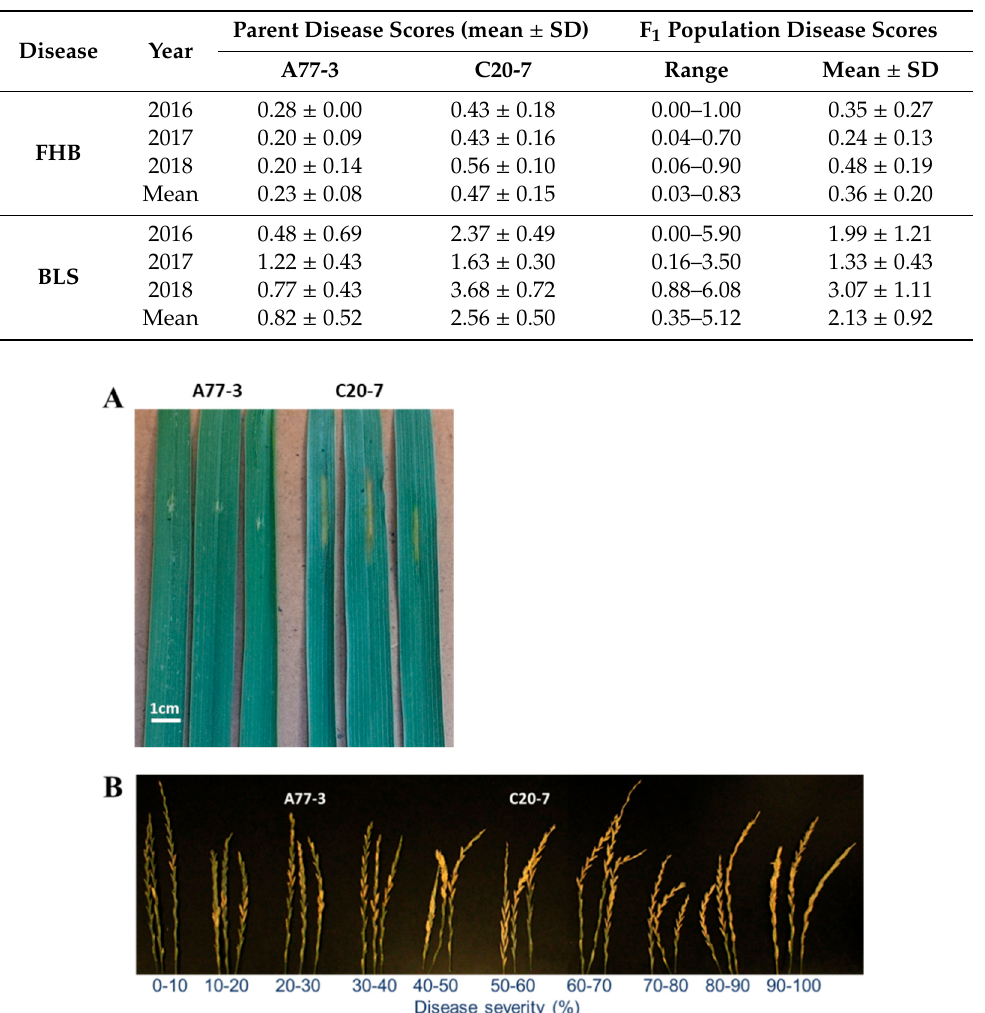
Table 1. Distribution of phenotypic data collected during 2016–2018 for Fusarium head blight (FHB) and bacterial leaf streak (BLS) in A77-3 × C20-7 IWG F 1 mapping population. Disease scale for FHB ranges from 0 to 1, where 0 is resistant and 1 is susceptible. BLS was assessed by recording lesion lengths (cm) as a form of discrete measurement.